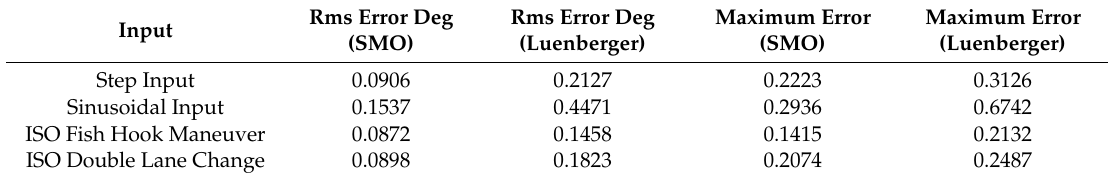
Table 2. RMSE comparison for Luenberger and Sliding mode observer in deg.